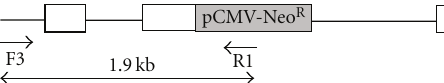
Figure 7: Targeted integration at the endogenous XPC4 locus: experimental design. The XPC4 target sequence is located in exon 9 of the XPC gene. Exons 8, 9, and 10 are shown in white boxes. Cleavage of the native XPC gene by the meganuclease yields a substrate for homologous recombination, which may use the repair plasmid depicted. Targeted integration events were detected by genomic PCR amplification carried out on neomycin-resistant